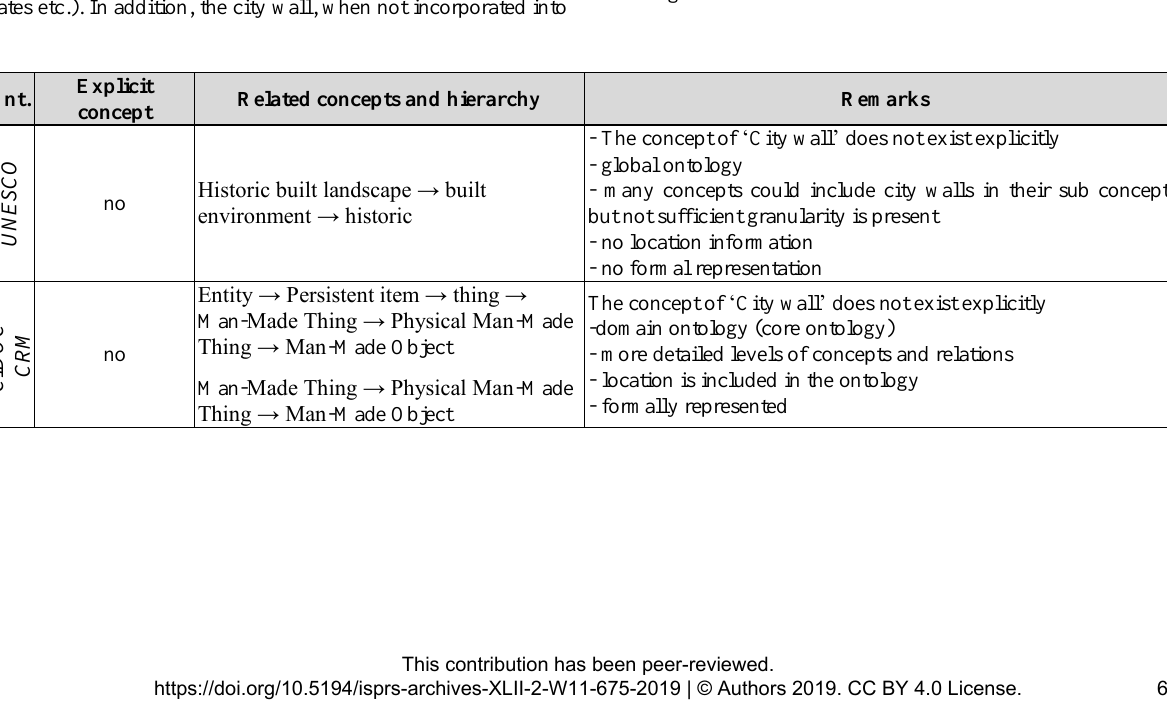
Figure 7. Some views of Norcia: the Ascolana gate, a small gate in the west side of the city wall, the fortified palace, the Saint Benedetto central square (patron of Europe).